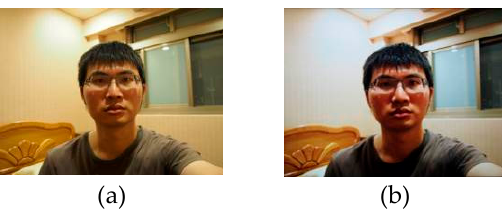
Figure 1. Spoofing the biometric system with retina identification technology. Demonstration of spoofing the biometric system with retina resolution display, ( a ) the actual filmed image, and ( b ) image reconstruction by an iPad with retinal display.